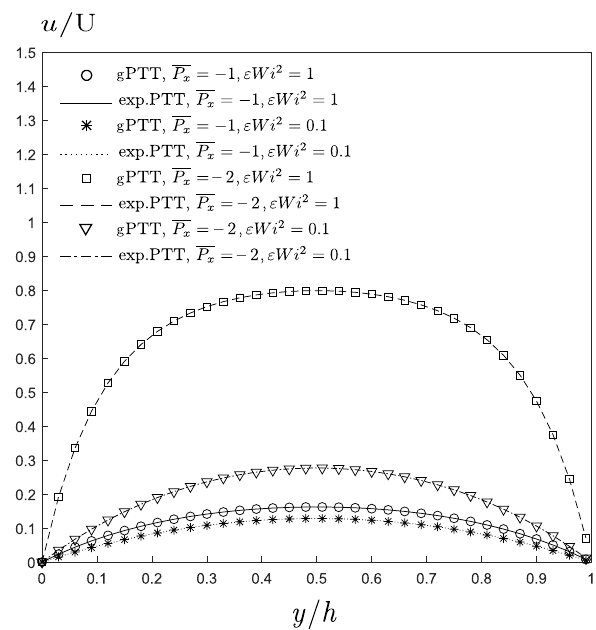
Figure 4. Comparison between the gPTT model and exponential PTT considering a Poiseuille flow with different values of ε Wi 2 and different values of imposed ¯ P x